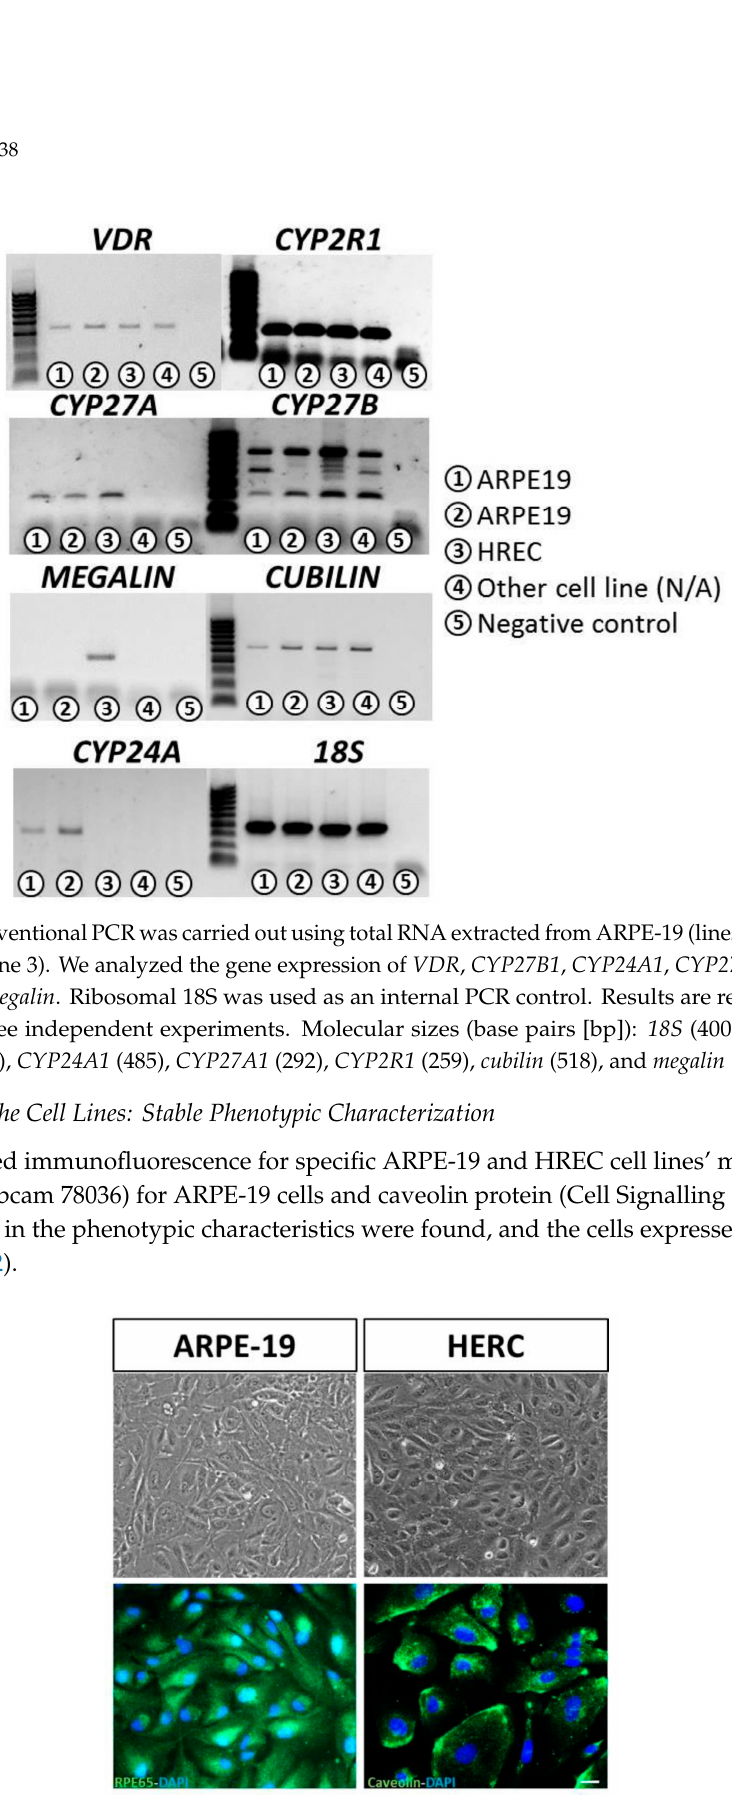
Figure 2. ARPE-19 and HREC cells’ phenotyping. Immunofluorescence of RPE65 (green) and caveolin (green) for ARPE-19 and HREC cell lines’ labelling, respectively. Upper panel shows cells at bright-field microscopy and down panel shows cells under fluorescence microscopy. Nuclei were labeled with 4 (cid:48) ,6-diamidino-2-phenylindole (DAPI) (blue). Scale bar: 20 µ